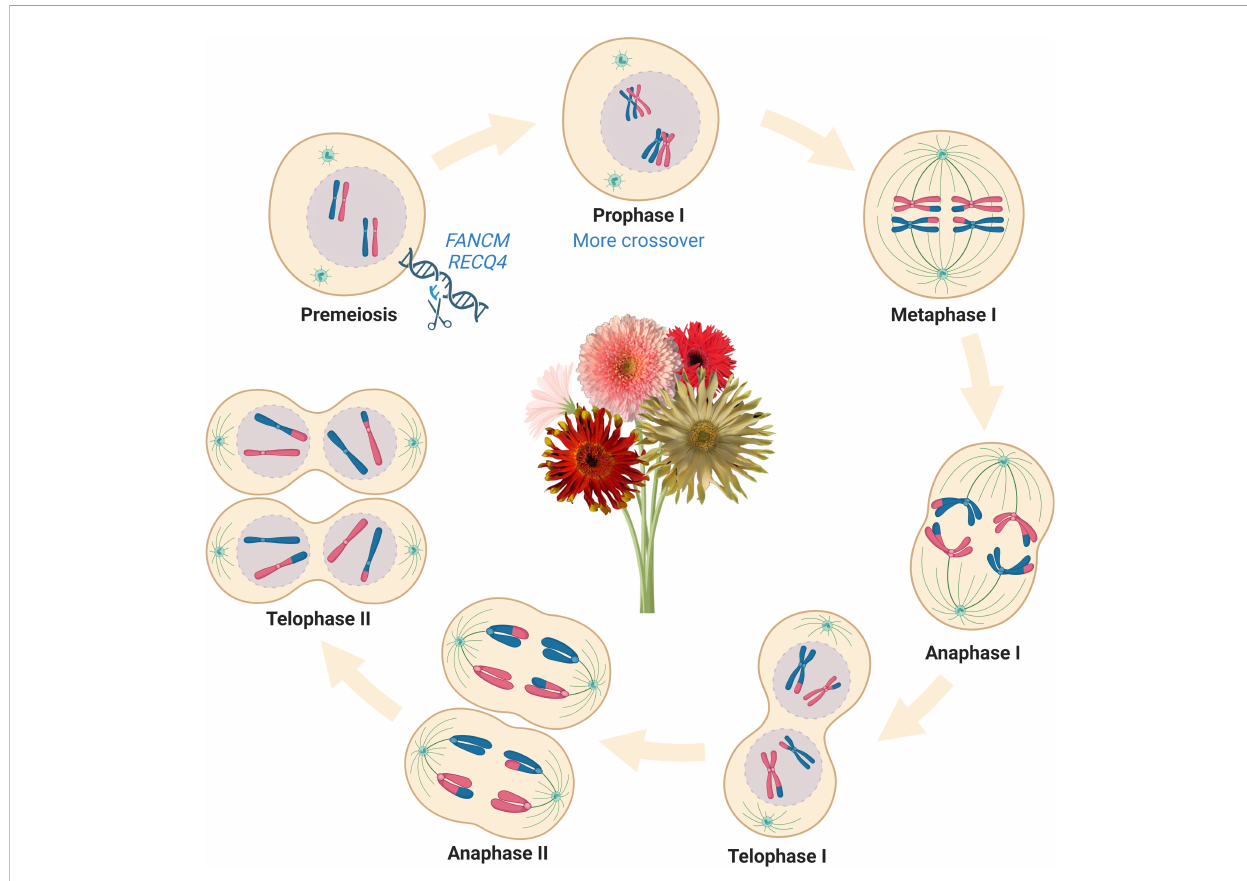
FIGURE 1 Manipulate meiotic recombination suppressors could boost massive crossover elevations in crop genomes and accelerate plant breeding programs. Knockout of FANCM and/or RECQ4 can massively increase the crossover frequencies and genetic recombination, which provides a novel strategy for enriching genetic diversity in plant breeding. Abbreviations include FANCM, fanconi anemia complementation group M; RECQ4, recombination- de fi cient Q gene family. This fi gure was created with